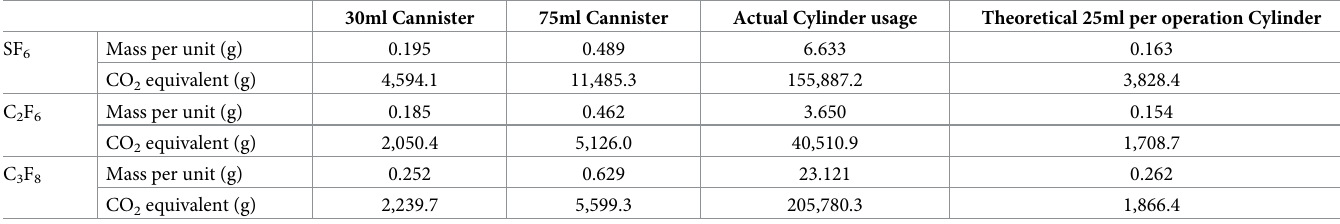
Table 3. Fluorinated gas mass per operation by source.